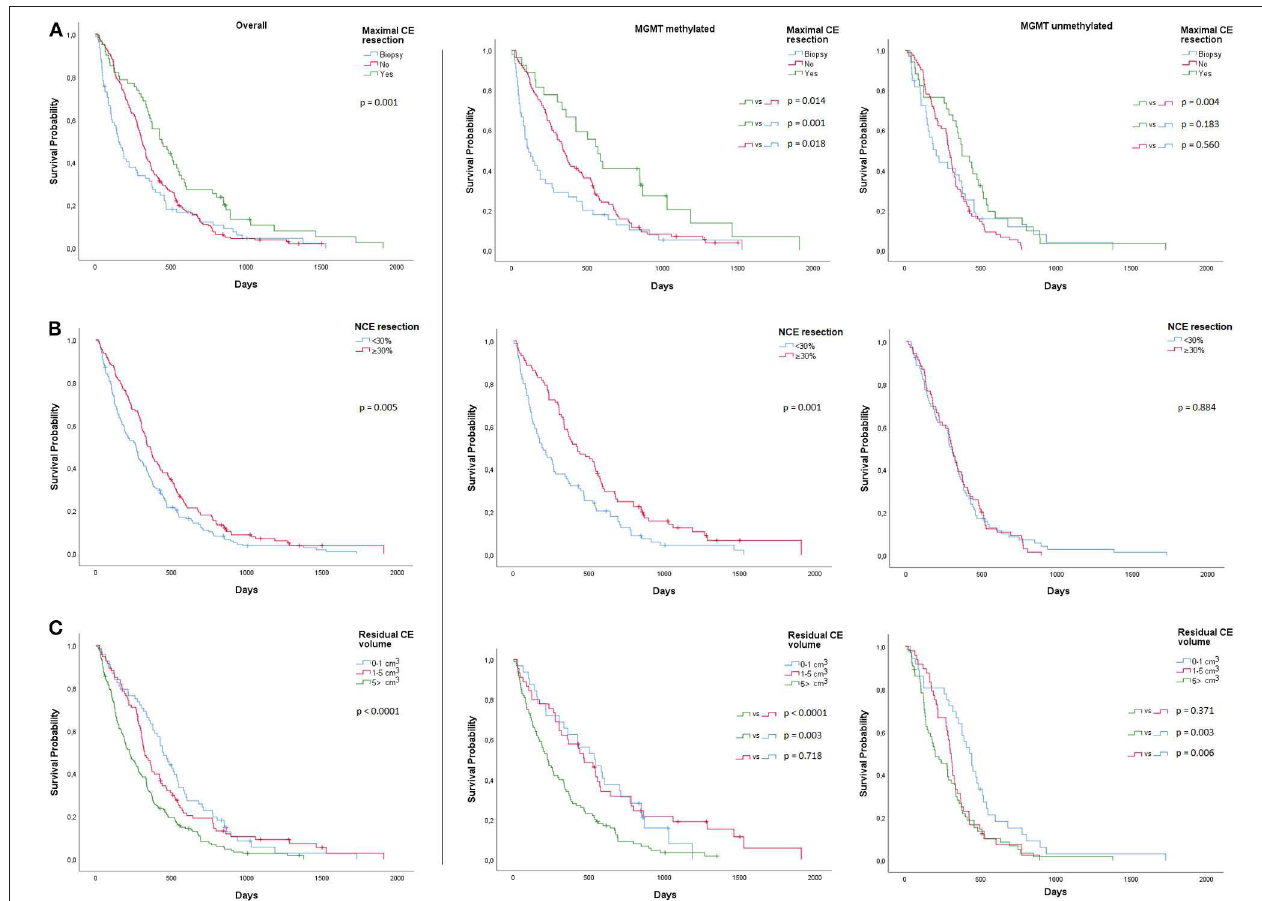
FIGURE 1 | Overall and MGMT-stratified Kaplan Meier curves for overall survival (A) Maximal CE resection (B) NCE resection and (C) CE residual